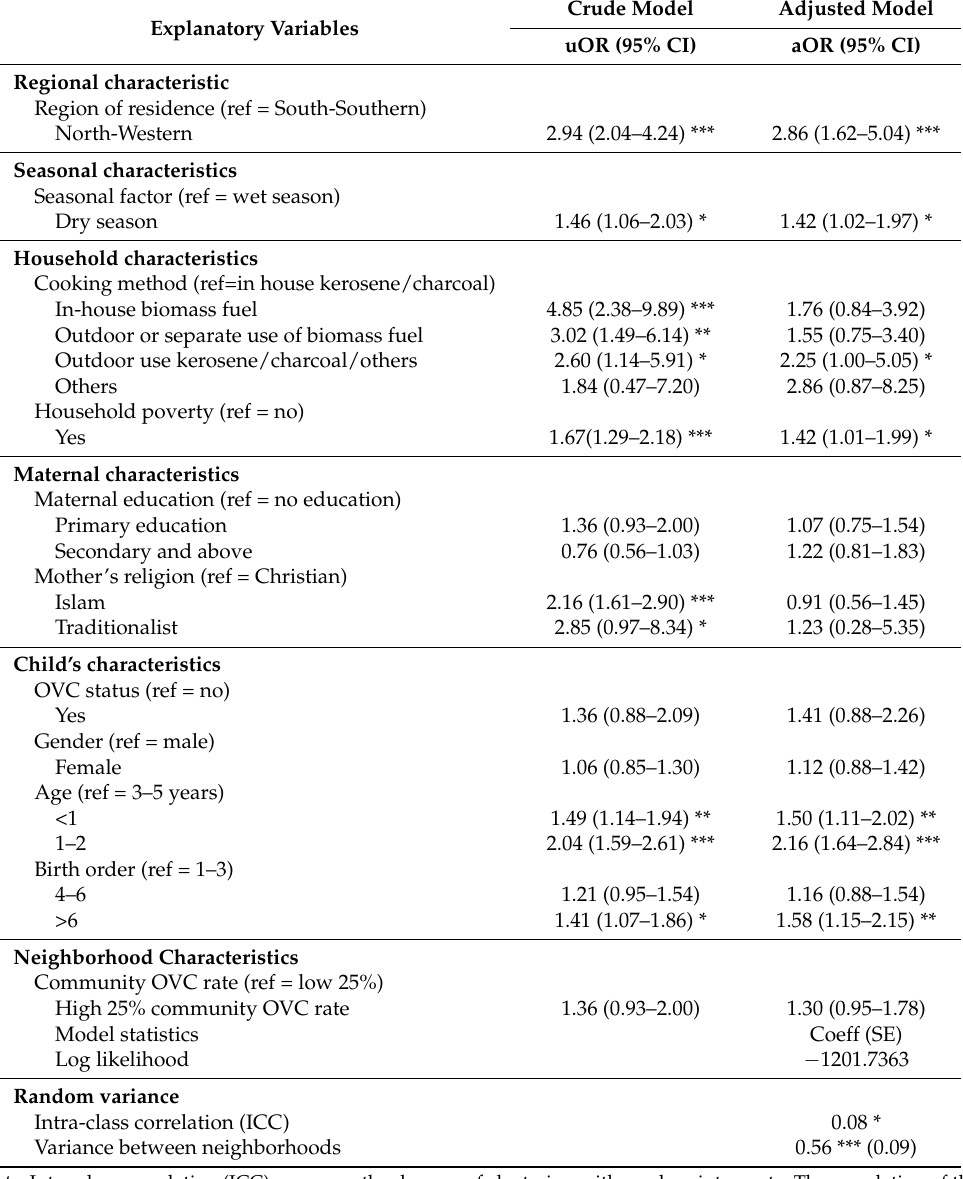
Table 2. Results from the multilevel logistic regressions for the odds of ARI symptoms among Nigerian preschool children from the North-Western and South-Southern communities, 2013 Nigeria Demographic and Health Survey